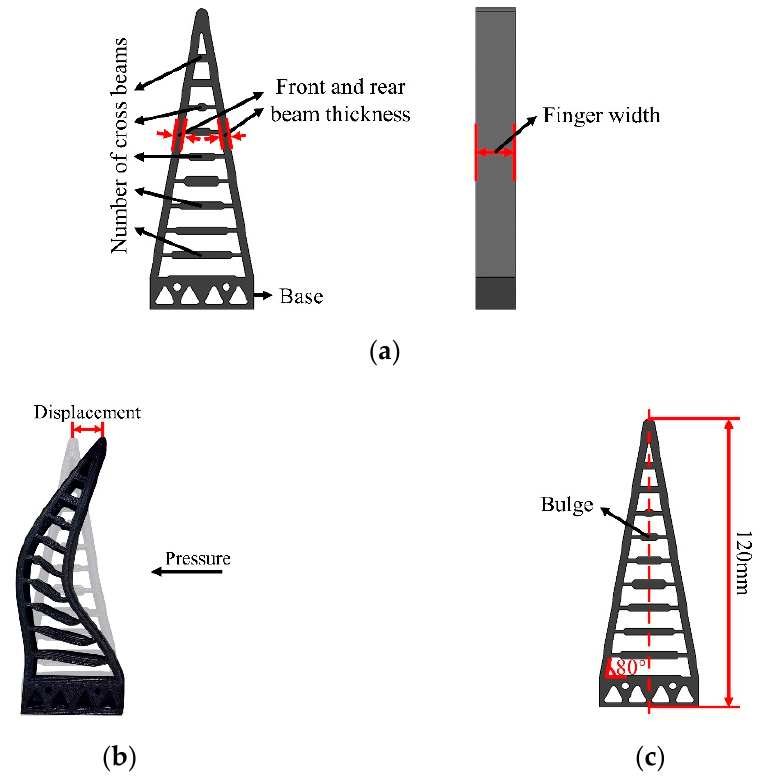
Figure 1. Characteristics of the Fin Ray finger: ( a ) basic components; ( b ) displacement of the fingertip; ( c ) structure of the Fin Ray finger.